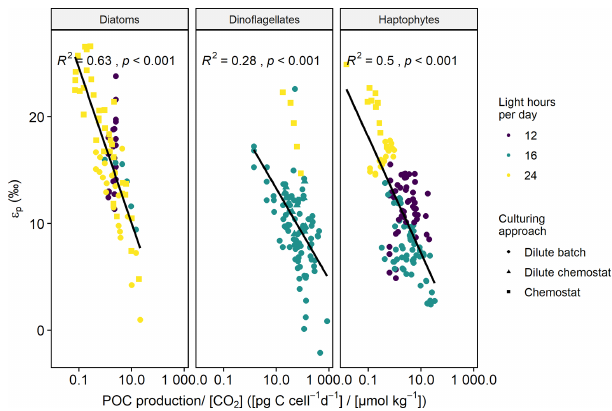
Figure 2. ε p against POC production / CO 2 (C-demand/C-supply; log-transformed) for the different phytoplankton groups, where the colored points indicate the respective light-dark cycle, and the shape of the points indicates the culturing approach. Black line illustrates the linear relationship ( R 2 and p -values indicated in the